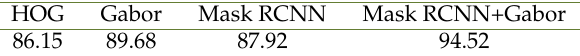
Table 4. Pedestrian detection test